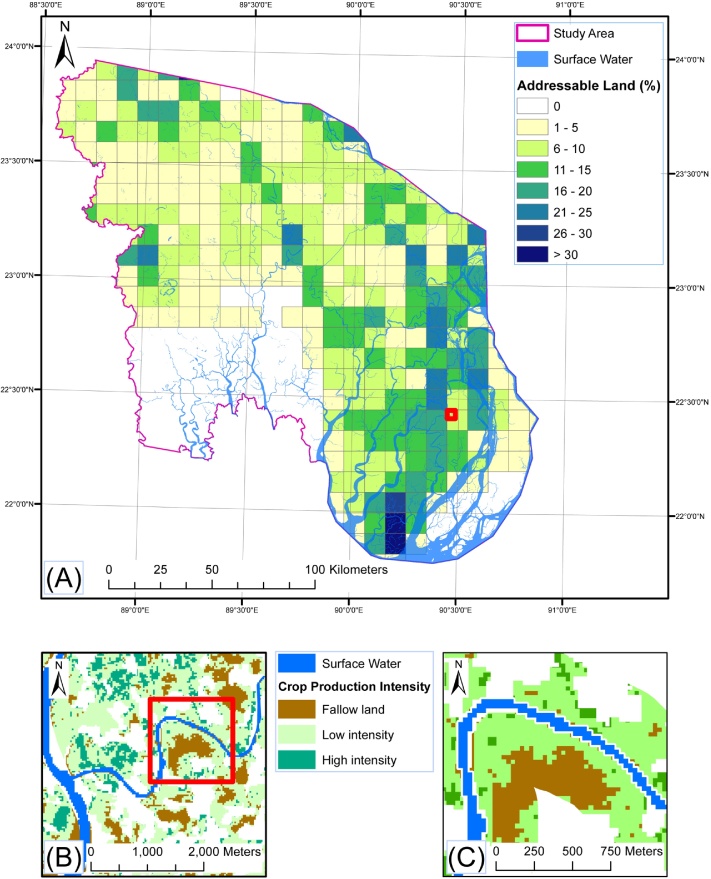
(A) Agricultural land suitable for surface water irrigation expressed as percentage of total cropland area in 100 km2 imposed grids. Low- and martinal potential croplands were excluded. (B) Detail of the red inset in Fig. 6A depicting a block of low-production intensity and fallow land proximal to surface water. (C) Further detail depicting the 385 m buffer indicating precise locations of fallow and low-intensity cropland upon which surface water irrigation could be used. Areas in white are non-agricultural land uses. Much of the white area adjacent to surface water in figure section C depicts the riparian buffer retained in our analysis to for conservation purposes. For interpretation of the references to colour in this figure legend, the reader is referred to the online version of this article.